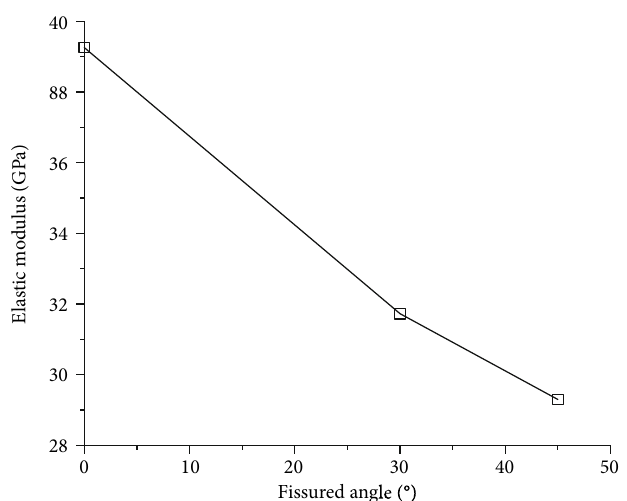
Figure 10: Variation of elastic modulus of fi ssured granites with α = 0 ° , 30 ° , and 45 ° .